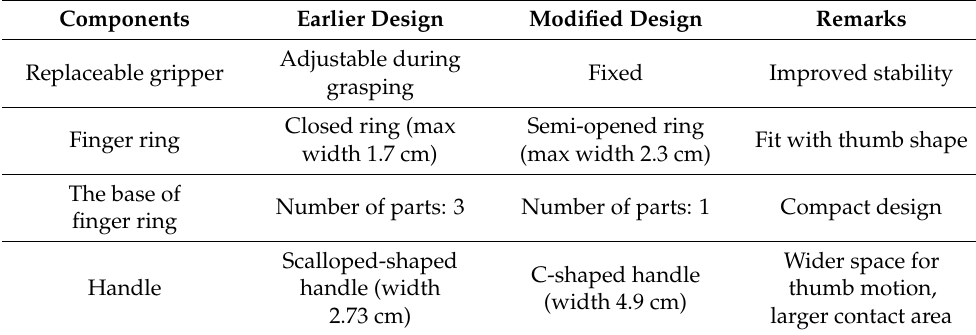
Table 2. Main design improvements and indicator dimension of